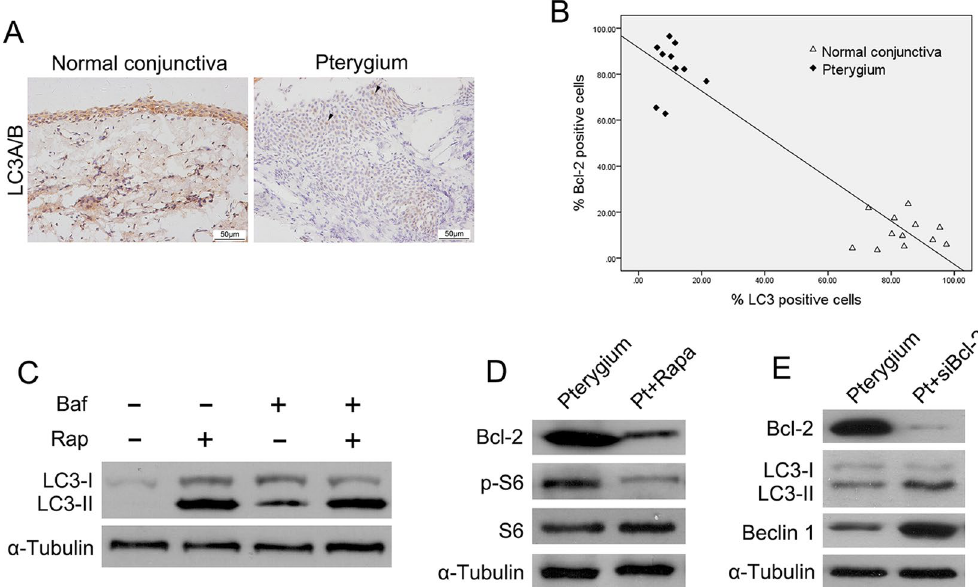
Figure 3. Activation of mTORC1 in pterygium regulates apoptosis by inhibiting Beclin 1 - dependent autophagy. ( A ) LC3-positve cells were observed in all epithelial cell layers of normal conjunctiva, whereas scarely any LC3-positive cells were detected in pterygium. ( B ) A statistically significant inverse correlation between LC3 and Bcl-2-positve cells (Pearson’s correlation: r = − 0.953, P < 0.01) was observed. ( C ) Western blot analysis of LC3 in cultured pterygium epithelial cells after treatment of rapamycin (100 nM), bafilomycin A1 (50 nM) or both. ( D ) Western blot analysis of Bcl-2 and p-S6 in cultured pterygium epithelial cells after rapamycin treatment. ( E ) Western blot analysis of Bcl-2, LC3 and Beclin 1 in cultured pterygium epithelial cells transfected with Bcl-2 siRNA. Scale bar, 50 μ